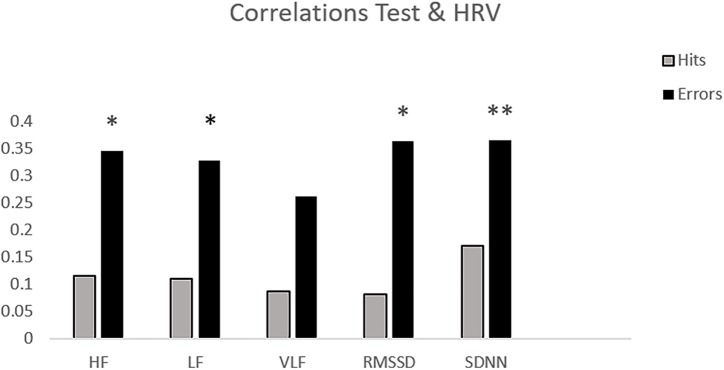
Bar chart of the correlations between HRV measures and subscores on CAMBIOS (corrects and errors). ∗p < 0.05; ∗∗p < 0.01 (two-tailed).